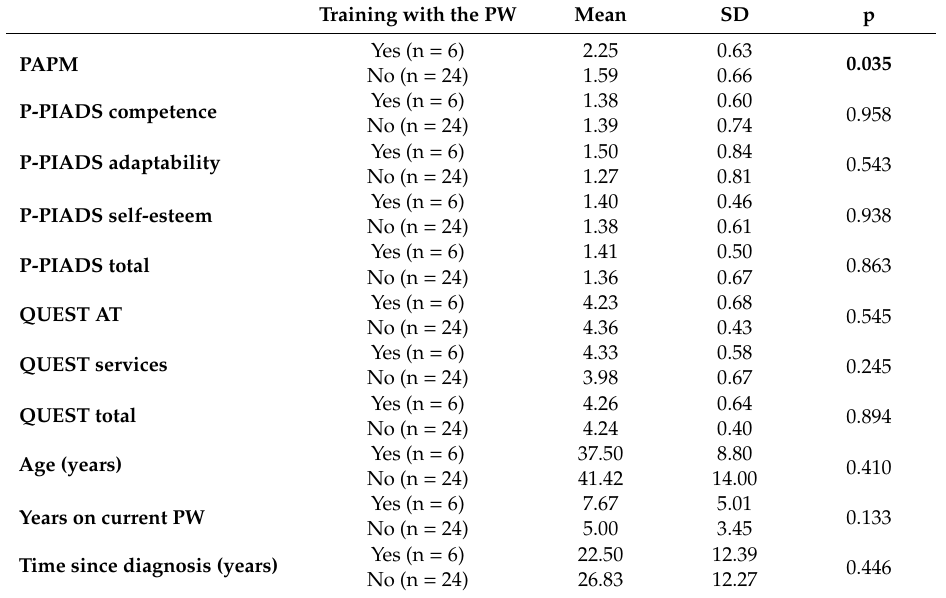
Table 5. Comparison of PAPM, P-PIADS and QUEST scores, age, number of years on the current PW and time since diagnosis, according to having or not received training oriented by professionals with the current PW. Training with the